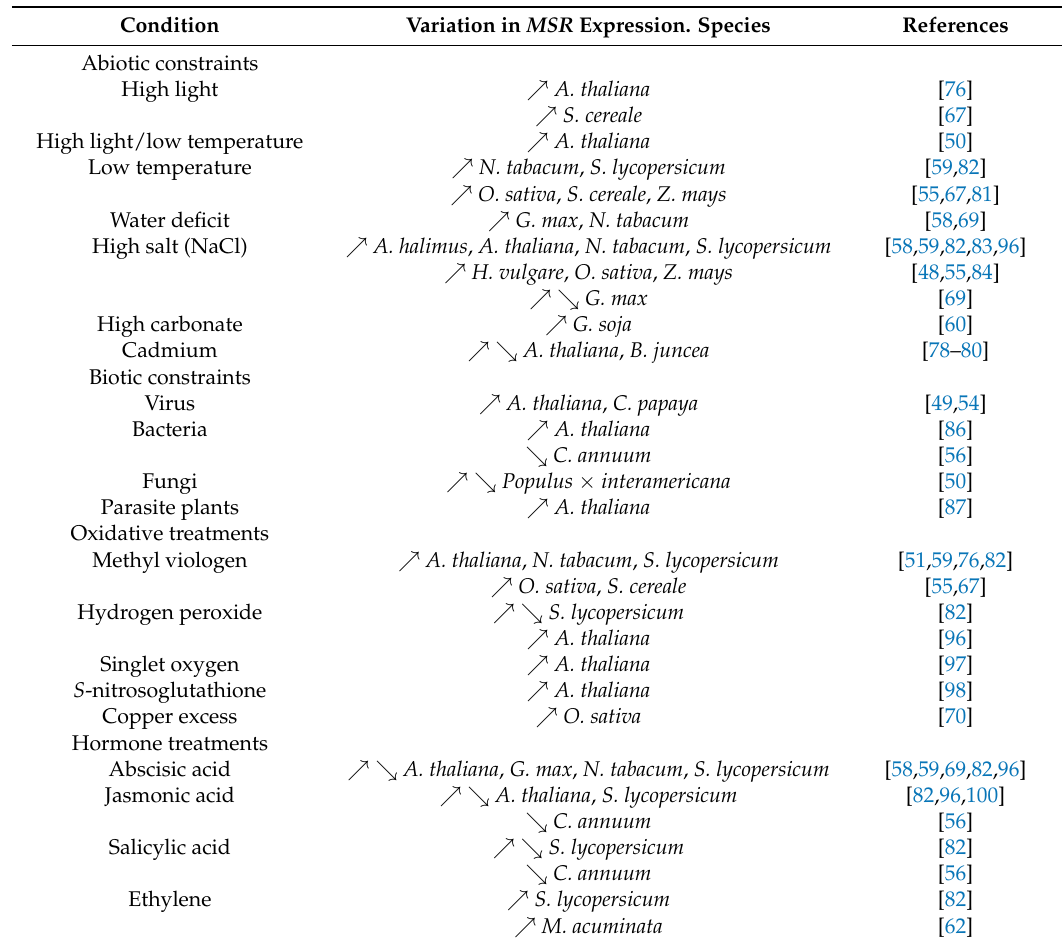
Table 1. Effects of various constraints and treatments on the expression of methionine sulfoxide reductases ( MSR ) genes in higher plants. The table was built from data gained on plants exposed to the mentioned constraints and treatments (in bold) either in vivo or in vitro. The cited reports aimed to investigate the expression of one or more MSR ( A or B ) genes at the transcript or protein levels. (cid:37) , the expression of at least one MSR gene is up-regulated; (cid:38) , the expression of at least one MSR gene is down-regulated; (cid:37) (cid:38) , the expression of at least two MSR genes is modified (up or